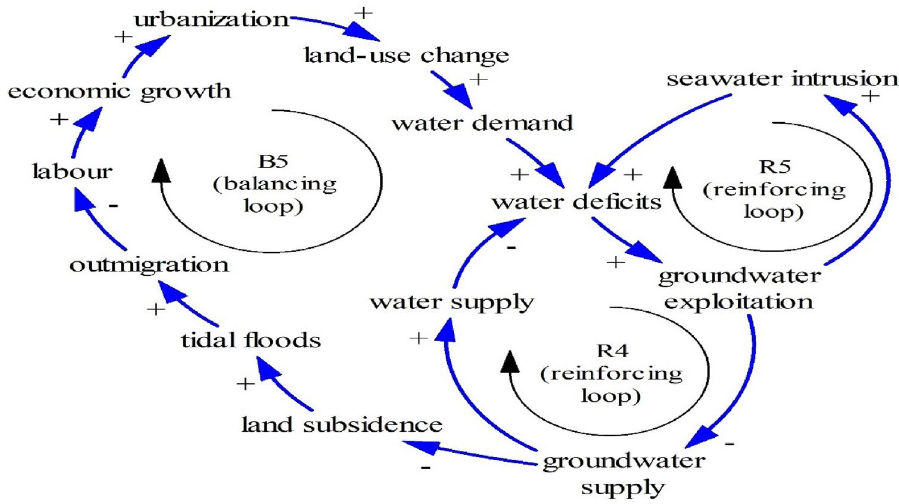
Figure 13. The Limits to Growth #5.